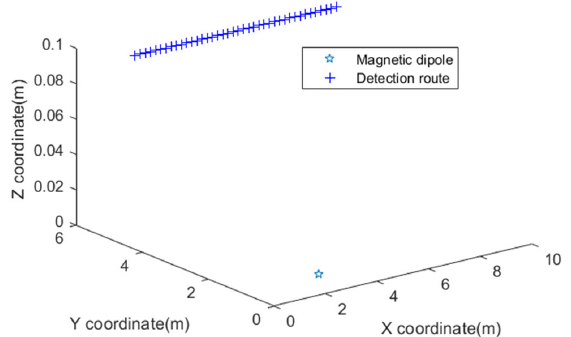
Figure 2. Schematic diagram of magnetic dipole and detection route.